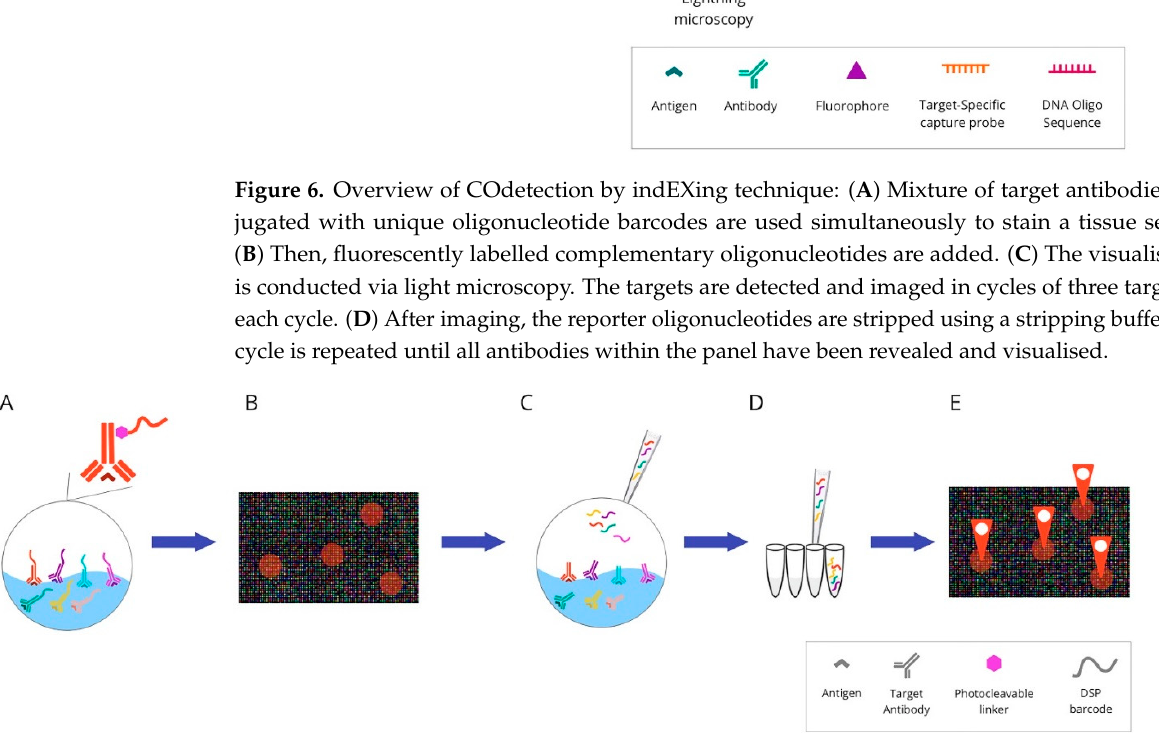
Figure 7. Overview of digital spatial-profiling technique: ( A ) Mixture of target antibodies conjugated with unique oligonucleotide barcodes through a UV photocleavable linker. ( B ) The oligonucleotide barcodes undergo quantitative analysis and are mapped back to tissue location to allow spatial profiling at the defined ROIs. ( C ) Sequential UV laser light exposure of each ROI results in the sample’s release of indexing oligonucleotide tags. ( D ) Then, a small pipette is robotically directed to the ROI and it samples all of the cleaved tags. ( E ) The counts are mapped back to tissue location, which produces a spatially resolved digital profile of analyte abundance within each ROI. Abbreviations: UV—ultraviolet; ROI—region of interest.